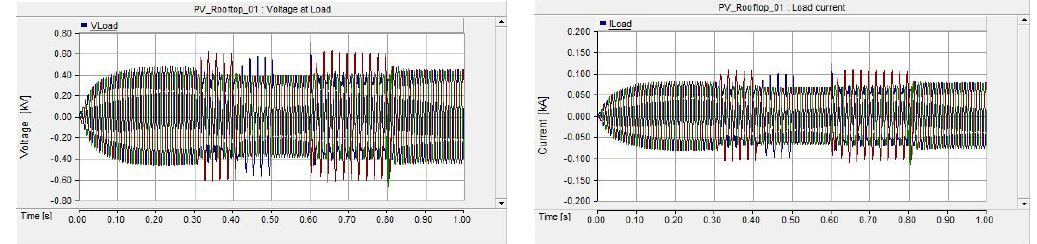
Figure 29. The voltage and current at the simulation load of a Suburban home.